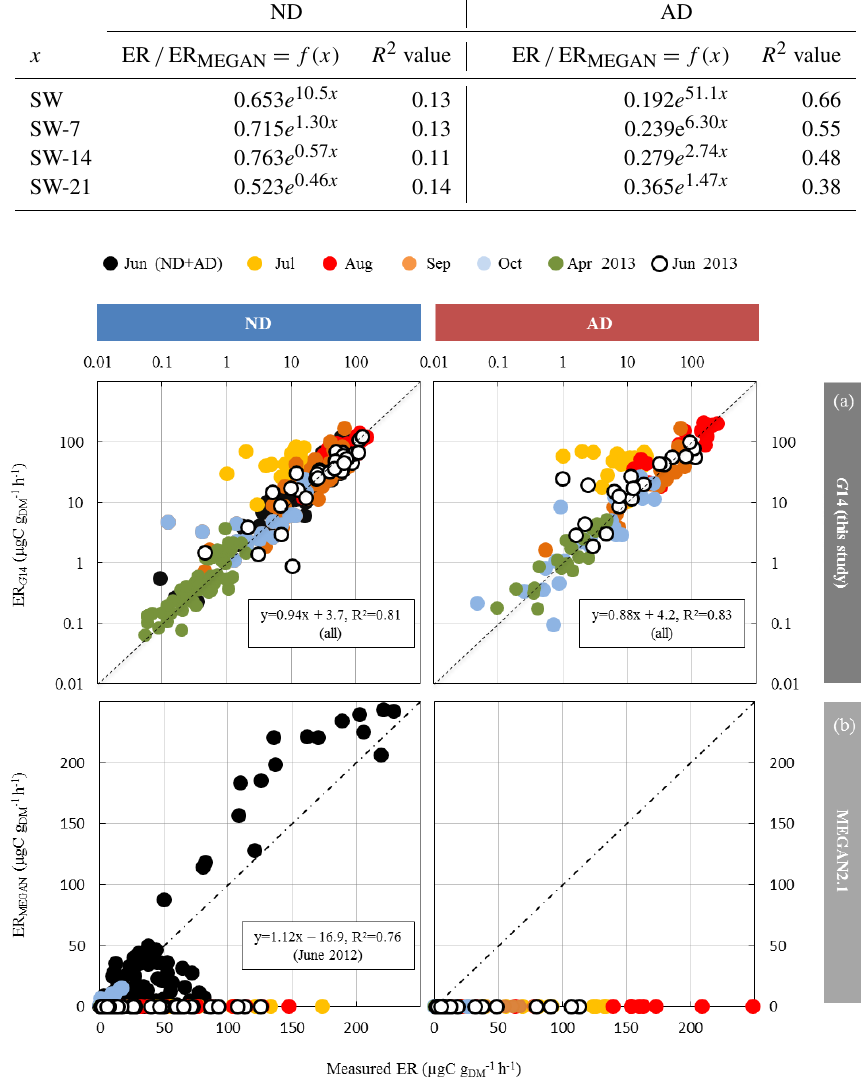
Figure 5. Calculated vs. measured isoprene emission rates (in µgCg − 1 h − 1 ) under ND ( n = 267) and AD ( n = 138) from June 2012 to DM June 2013, using the ( a ) G 14 (this study) and ( b ) MEGAN2.1 isoprene model (Guenther et al., 2012) with a wilting point value θw of 0.15m 3 m − 3 (measured at the O 3 HP). The dotted line is the 1 : 1